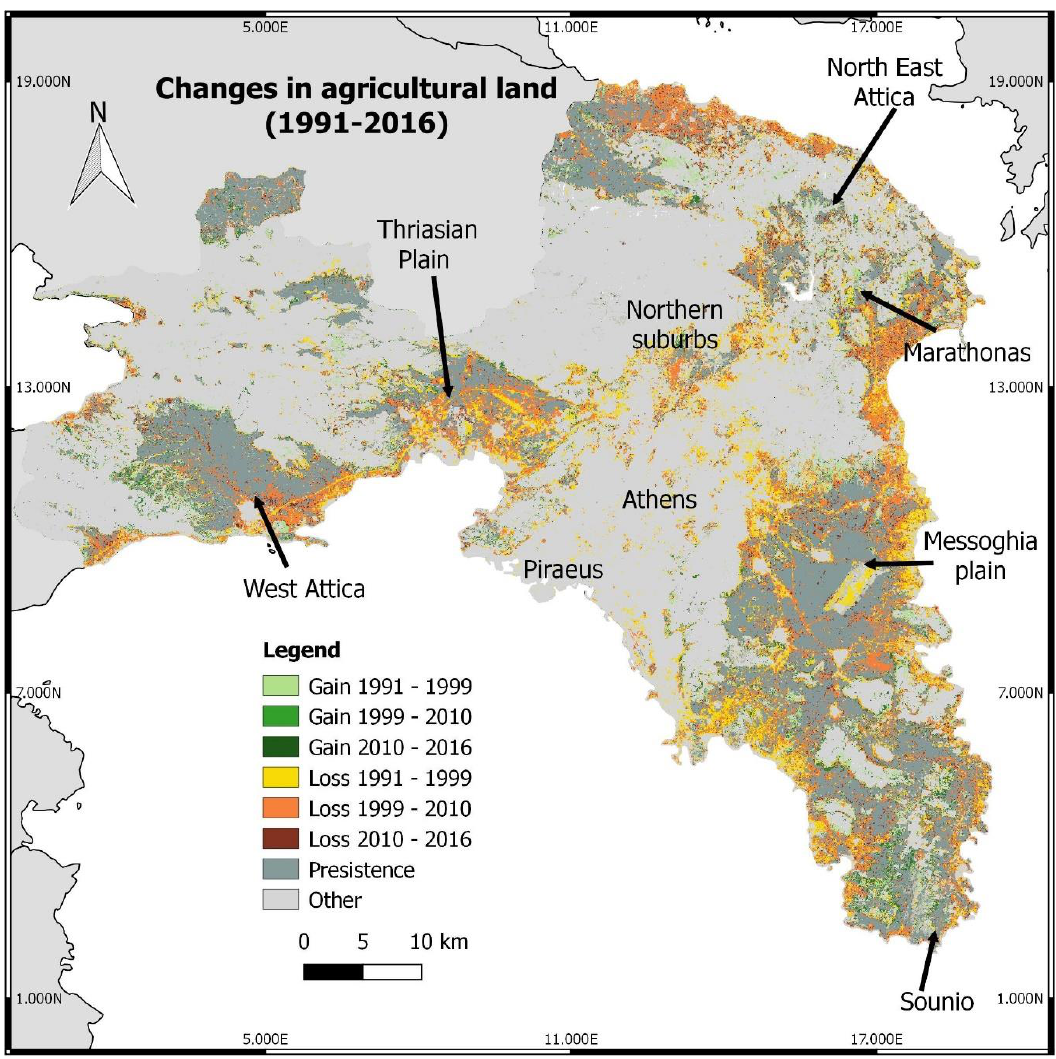
Figure 5. Changes in agricultural land observed between 1991 and 2016.